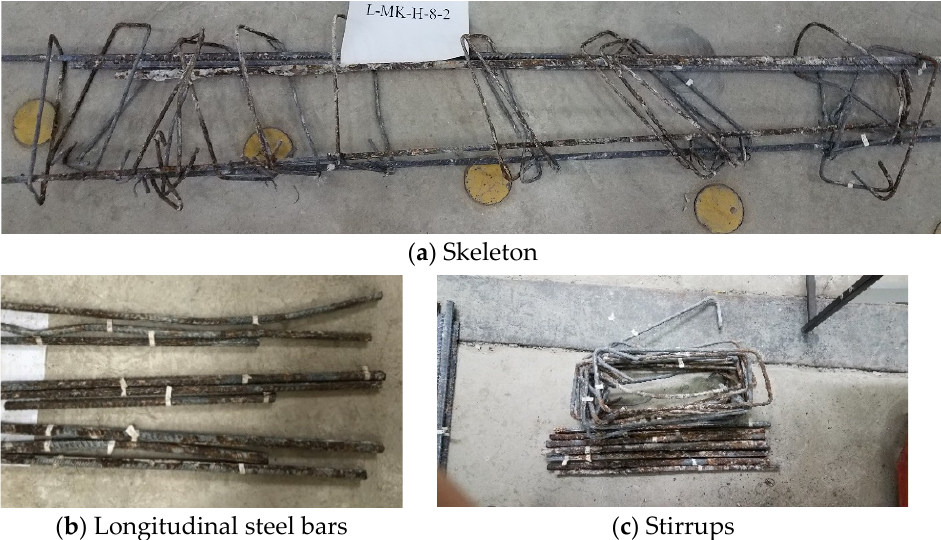
Figure 8. Corroded steel bars from degraded reinforced concrete beams: ( a ) skeleton, ( b ) longitudinal steel bars and ( c ) stirrups.